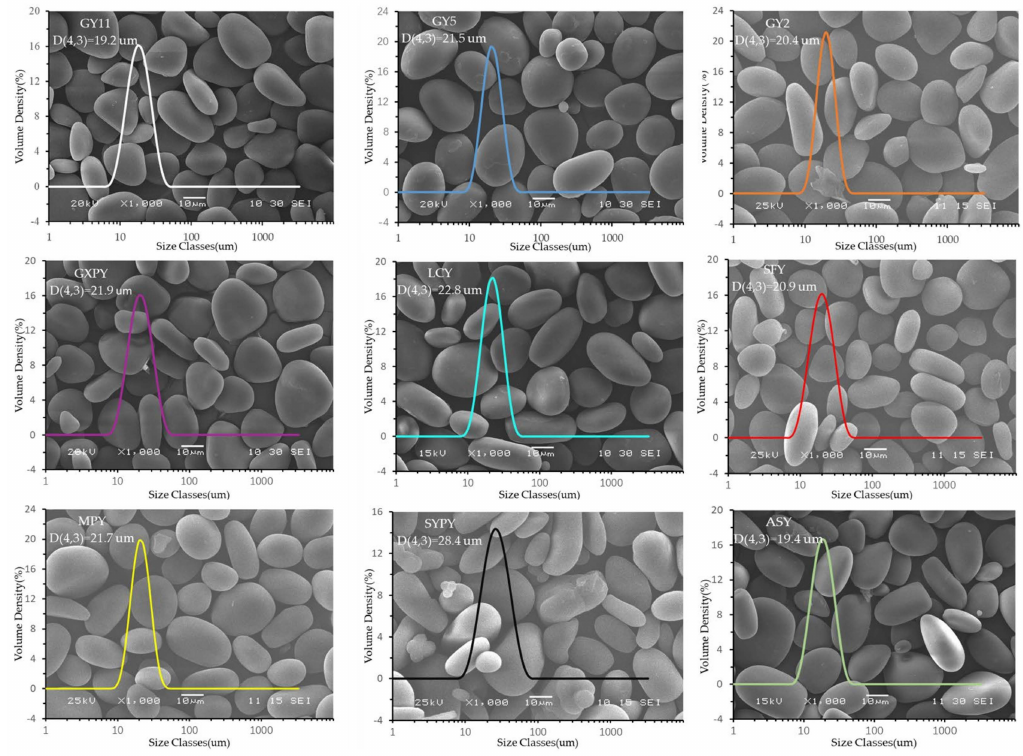
Figure 2. SEM micrographs and particle size distribution of yam starch.